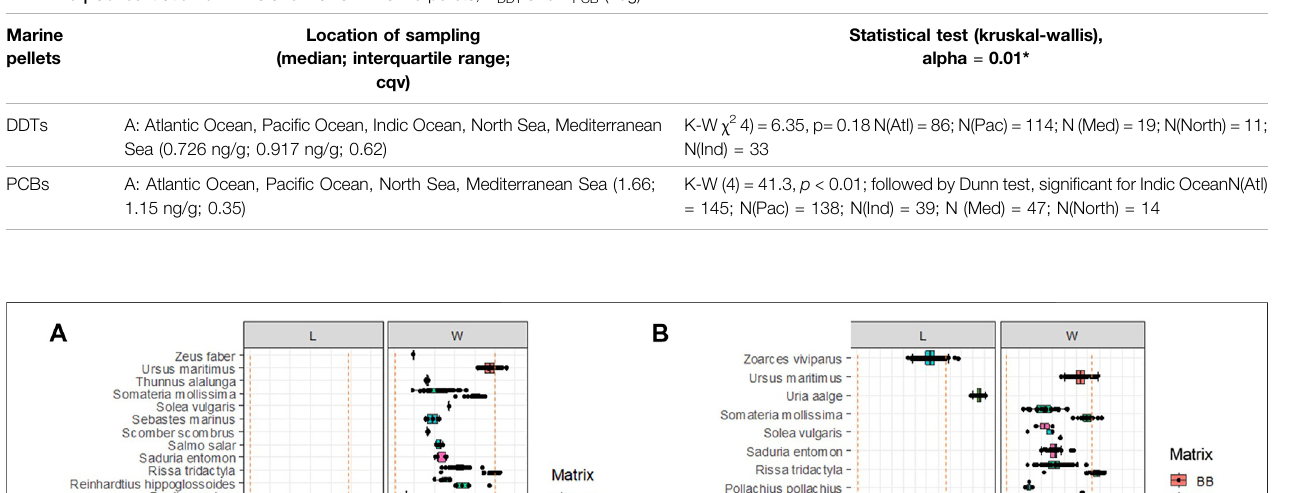
Frontiers in Environmental Science |